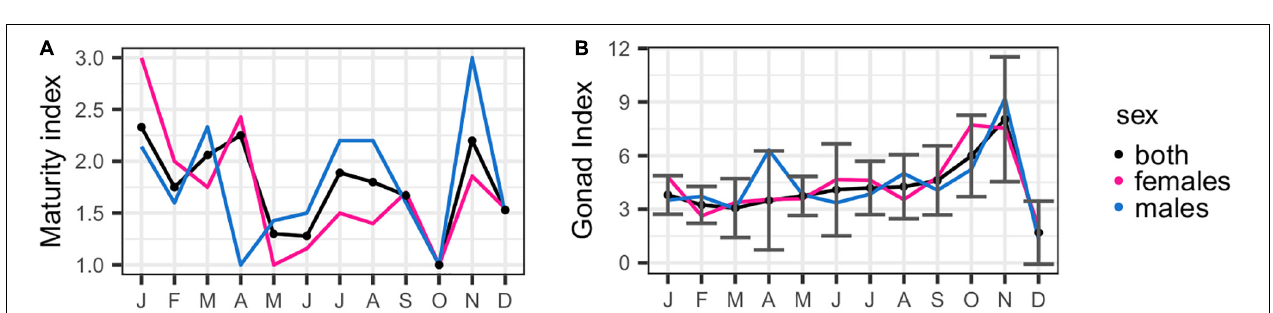
FIGURE 5 | Monthly evolution of maturity index (A) and gonad index (B) of the Sphaerechinus granularis in Madeira archipelago.